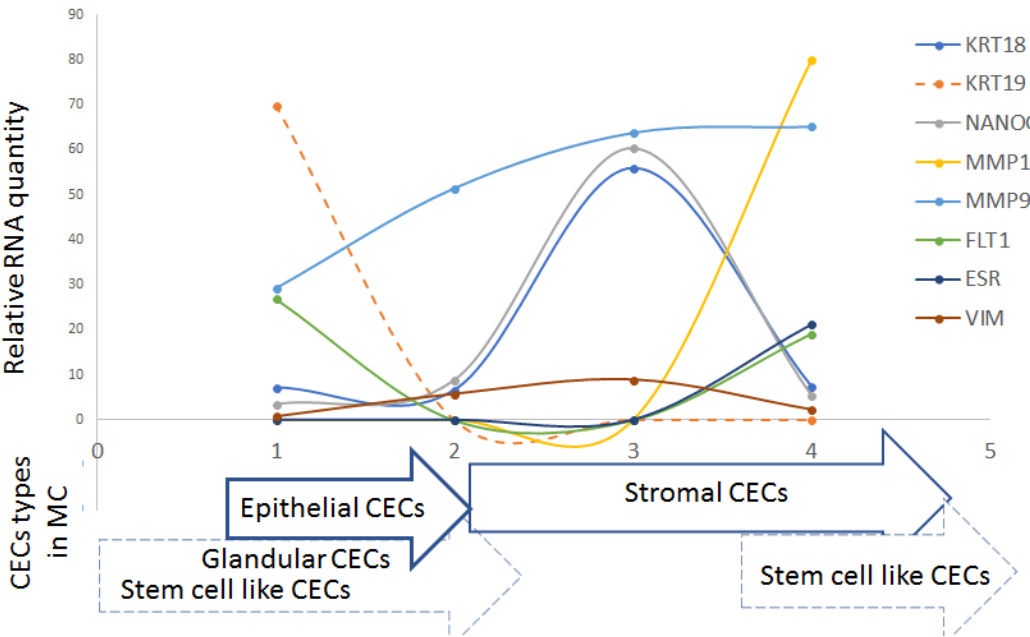
Figure 4. Gene expression changes in CECs during the menstrual cycle (MC; four examinations) are shown in relation to CECs cytomorphology type: epithelial, stromal, stem-cell like, glandular. Examination No. 1 (day 24 of MC), No. 2 (day seven of MC), No. 3 (day 14 of MC), No. 4 (day 21 of MC). The values are presented as relative RNA amount.